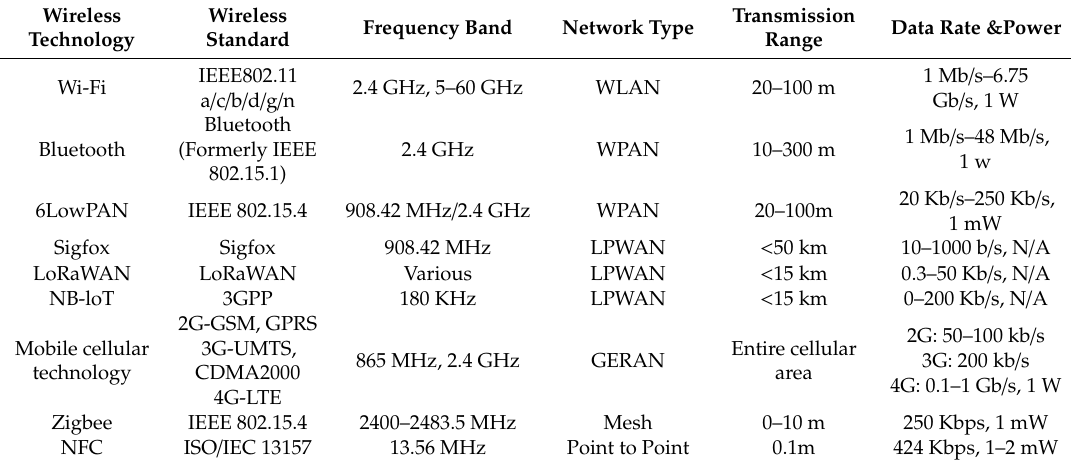
Table 1. Summary of popular wireless technologies and basic